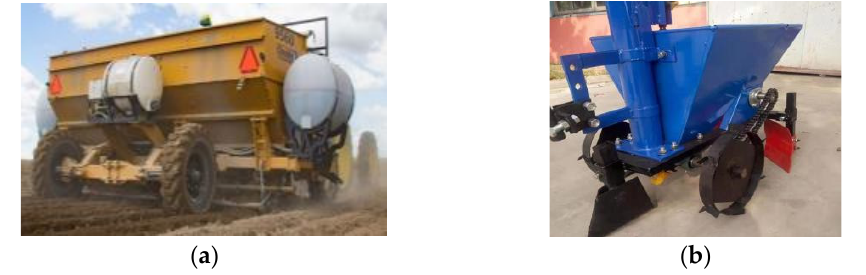
Figure 1. Different types of potato planters, they should be listed as: ( a ) large combined potato planter. Reprinted with permission from ref. [12]. Copyright 2021 Double L Industries; ( b ) small potato planter.